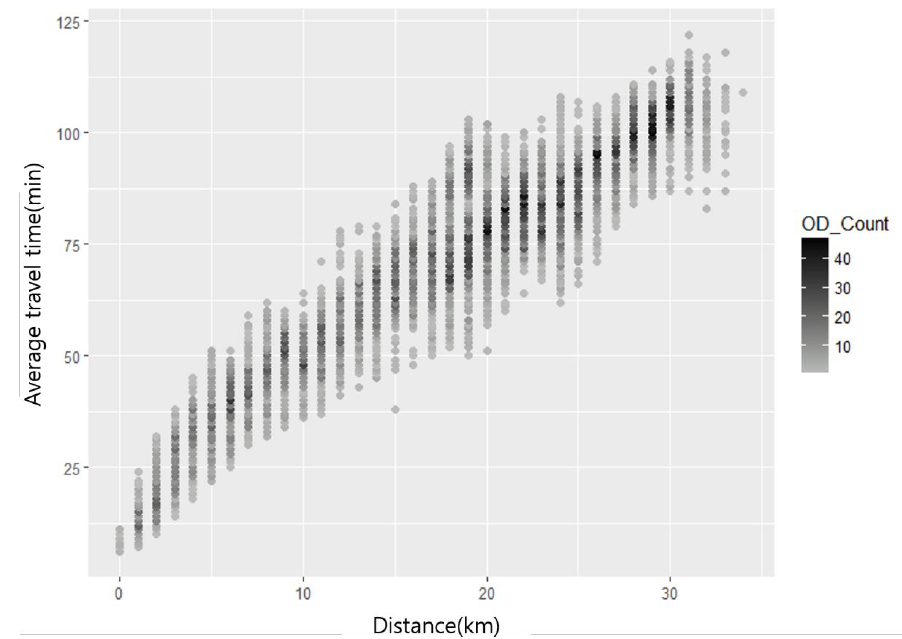
Figure 3. Distribution of all O-D pairs according to shortest distance and average travel